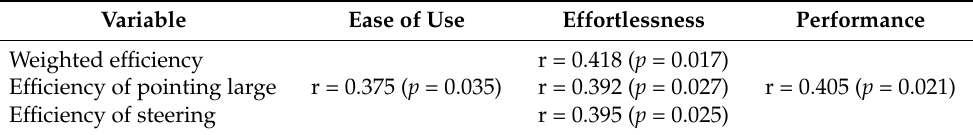
Table 7. Pearson correlation factor values achieving significance ( p < 0.05) for the association of objective and subjective usability evaluation measures, restricting to participants with large hand size ( n =